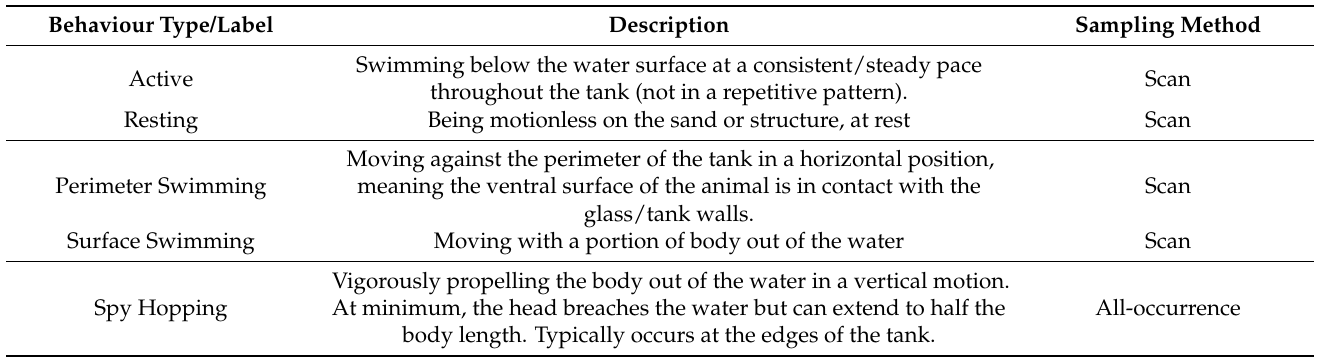
Table 1. Behavioural ethogram used for elasmobranch and teleost species in tank pre-post renovations. The sampling method indicates whether the behaviour was sampled using the instantaneous scan sampling method every five minutes during the observation period or using the all-occurrences method throughout the observation period. Behaviour Type/Label Description Sampling Method